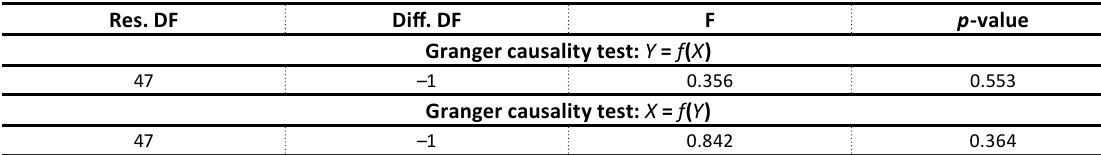
Table E3. Granger causality test: rank ( X ) and GCESG ( Y ) Res. DF